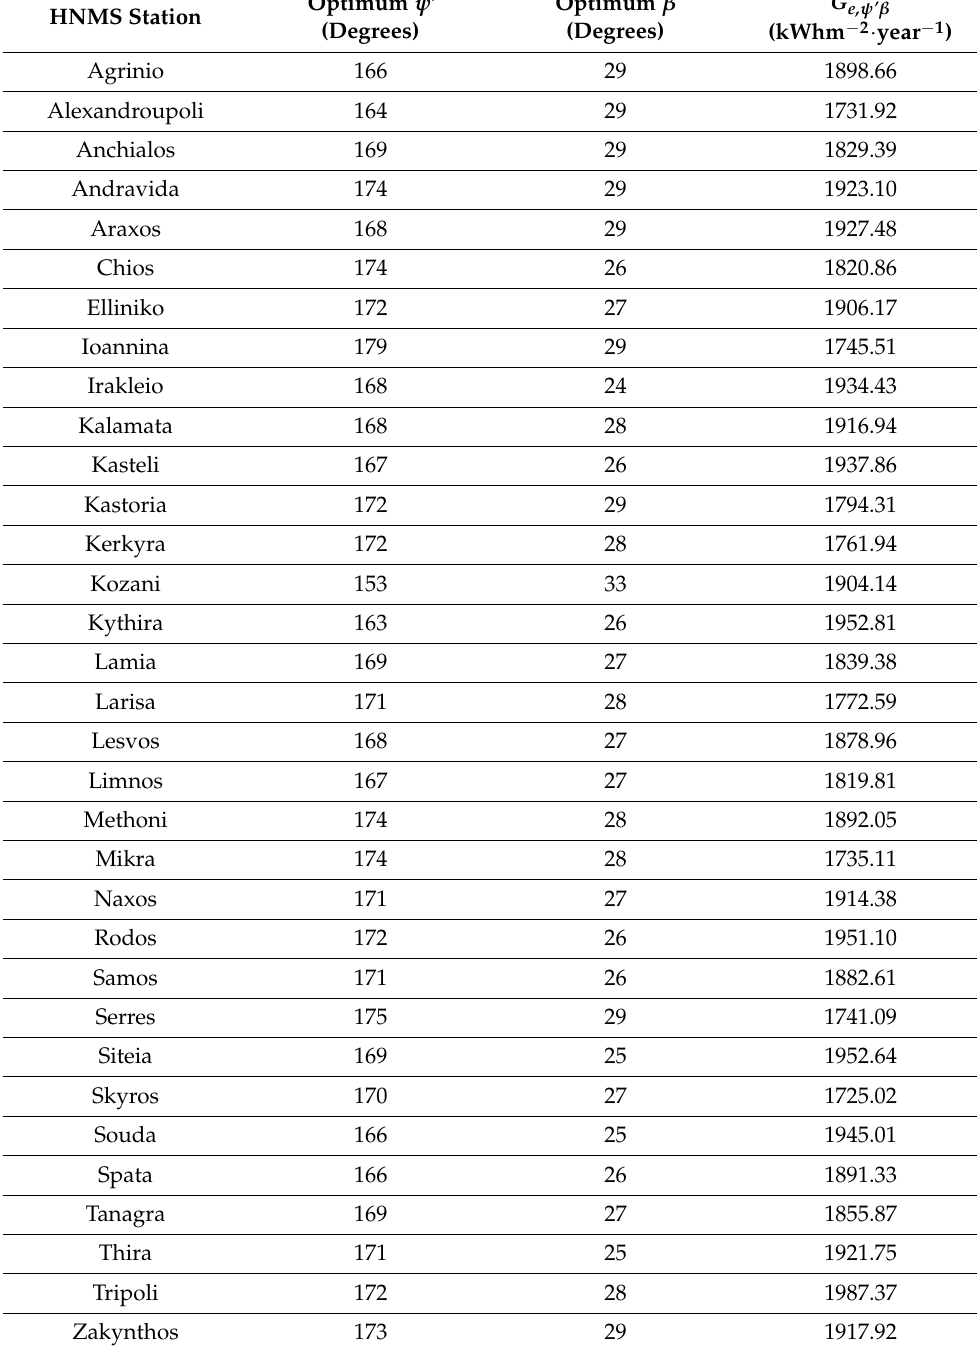
Table 8. Maximum annual solar energy G e , ψ ’ β received at the 33 sites in Greece (in alphabetical order) on inclined surfaces having specific azimuth ψ ’ and tilt β